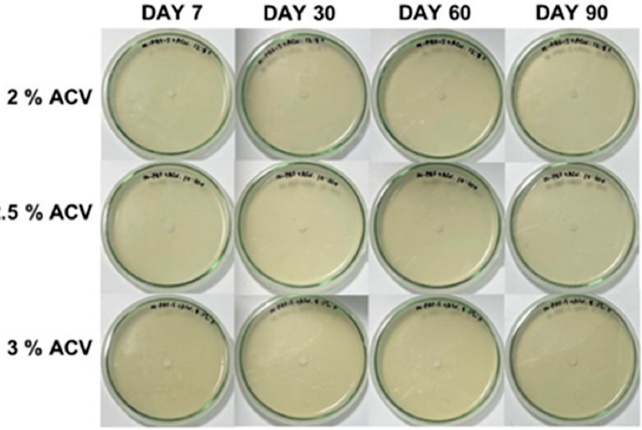
Figure 6. The growth of A. niger in the m-PAF and ACV/m-PAF adhesives after 7, 30, 60, and 90 days of storage.